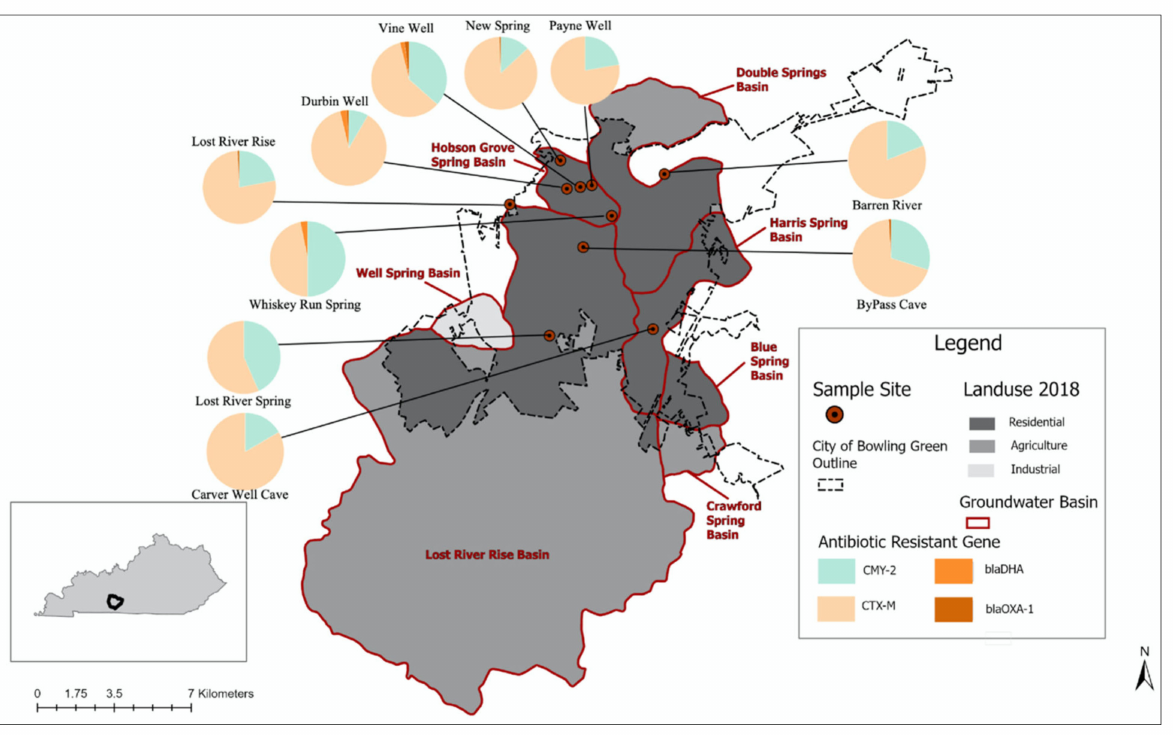
Figure 8. Spatially represented beta-lactam ARG detection frequency associated with resistance phenotypes for E. coli and landuse in Bowling Green, KY urban karst